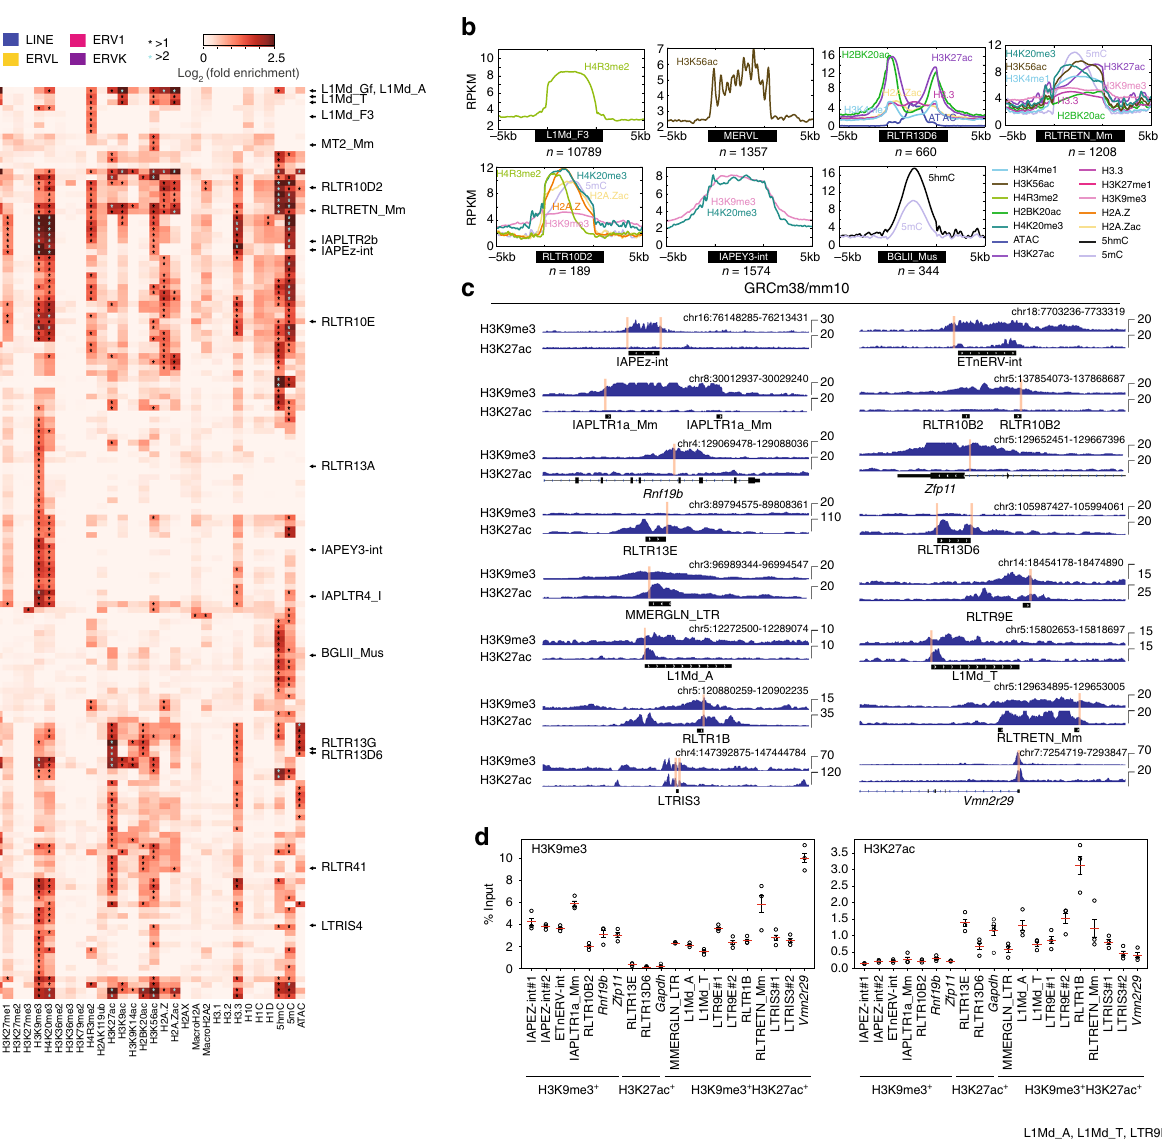
Fig. 1 TEs are marked by TE-type-speci fi c epigenetic signatures. a Heatmap of 32 chromatin marks in normal serum-grown ESCs and their fold-enrichment at the indicated TE types. The RPKM (reads per kilobase of TE per million library sequence reads) was measured for all copies of that TE type, and each TE type was treated as a metagene. Fold-enrichment over background was calculated by measuring the RPKM for each TE type, taking the maximum binned value, and comparing this to size matched, randomly selected genomic regions. A chromatin mark was considered enriched if it was > 2-fold enriched (marked with an asterisk). Those TE types > 4 fold-enriched are indicated with a cyan asterisk. See Supplementary Data 1 for detailed sample information. The full heatmap and table for all TE types is in Supplementary Figure 1b and Supplementary Data 2. b Read count tag density pileups (In RPKM) of the indicated chromatin marks for the selected TEs. The TEs were scaled to the same size, and the fl anking 5 kb regions are shown. n = indicates the number of TEs used in that pileup, for this and all subsequent pileup fi gures. c , d Native-ChIP-qPCR using antibodies against H3K27ac and H3K9me3 for selected TEs, measured as percent of input. The location of the primer pairs are indicated with red lines in the genomic views in ( c ). See Supplementary Data 7 for the primer pair sequences. Genomic locations are from the mm10 mouse assembly, for this and all other genomic fi gures. The scale of the pro fi les ranges from a baseline of 0 up to the indicated value, in normalized arbitrary units, for this and all subsequent genome views. Native-ChIP-qPCR ( d ) was performed three times in biological replicate each with three technical replicates, the open circles indicate the mean of the technical replicates, the red bar is the mean of the biological replicates, and the error bars are the standard error of the mean. Source data are provided as a Source Data fi le